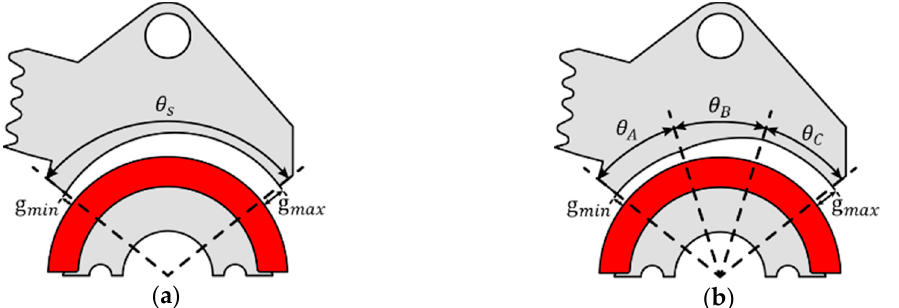
Figure 3. Two types of asymmetric air gap: ( a ) tapered air gap; ( b ) stepped air gap.